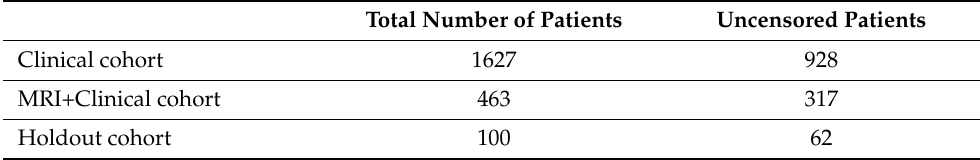
Table 1. Cohorts and the number of patients in the